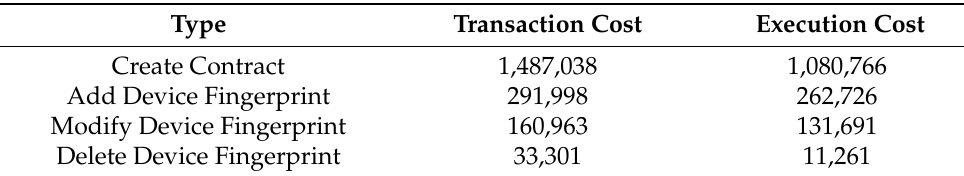
Table 5. Gas consumption.